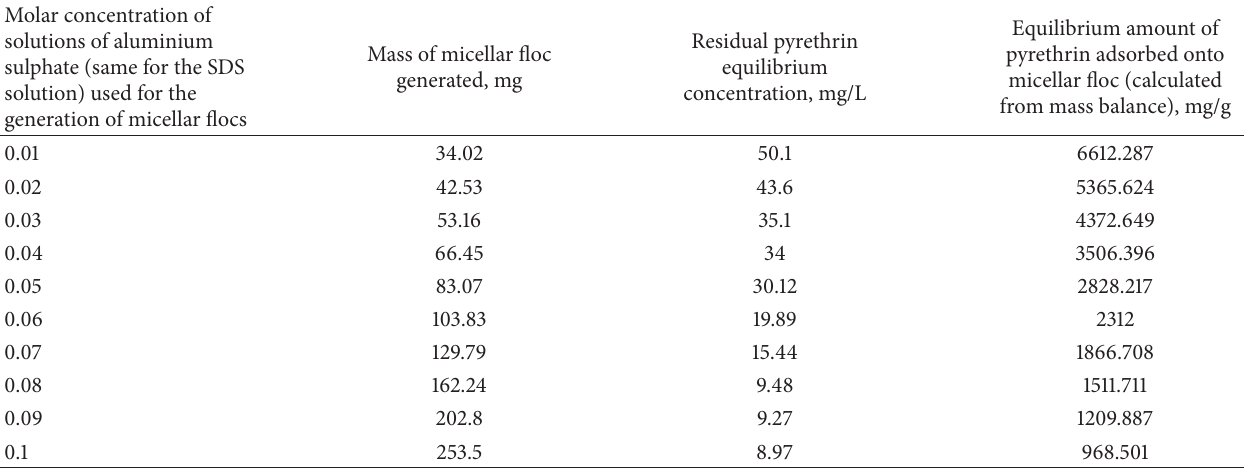
Equilibrium amount of Residual pyrethrin Mass of micellar floc pyrethrin adsorbed onto equilibrium generated, mg micellar floc (calculated concentration, mg/L from mass balance), mg/g